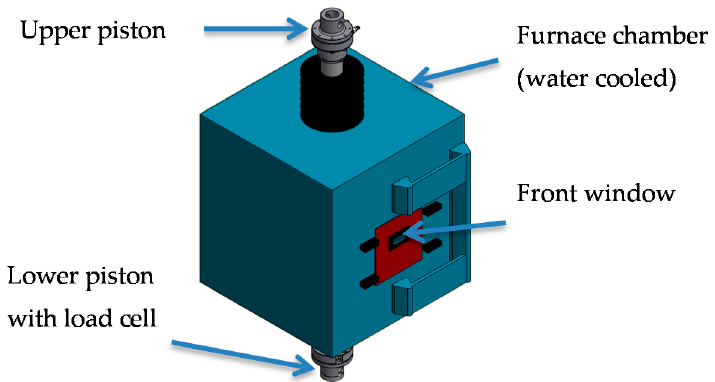
Figure 3. Gas-tight furnace (courtesy of Messphysik).